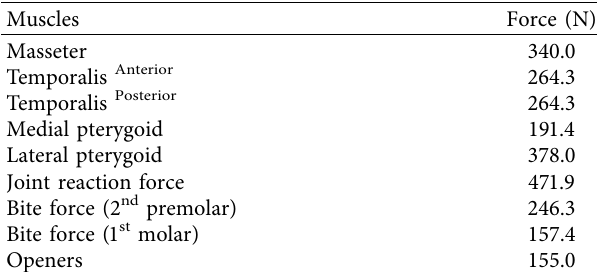
Figure 3: Meshed model of the implant. Table 1: Calculated muscle, joint reaction, and bite force magnitudes.